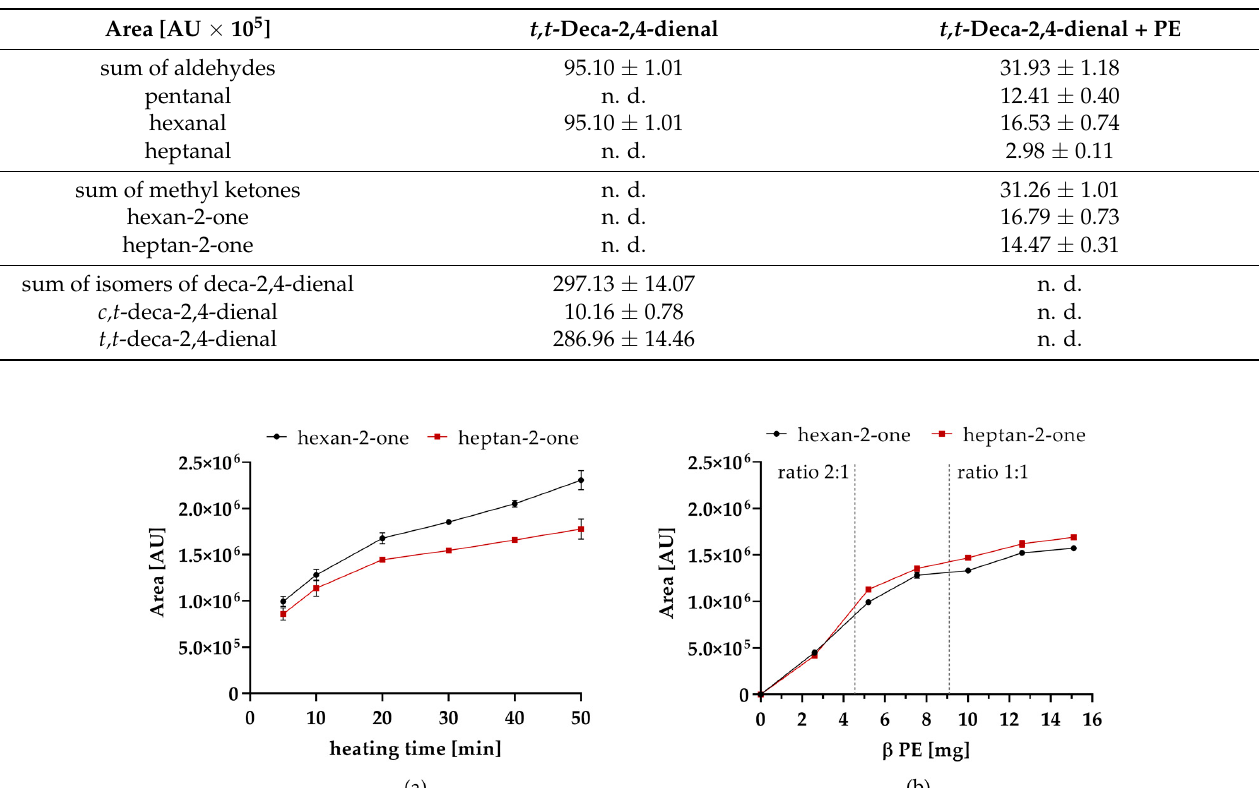
Table 3. Comparison of peak areas of formed carbonyl compounds from 0.05% t,t -deca-2,4-dienal each with and without PE after 20 min at 160 ◦ C and analyzed by HS-GC-MS, n. d. = not detectable.